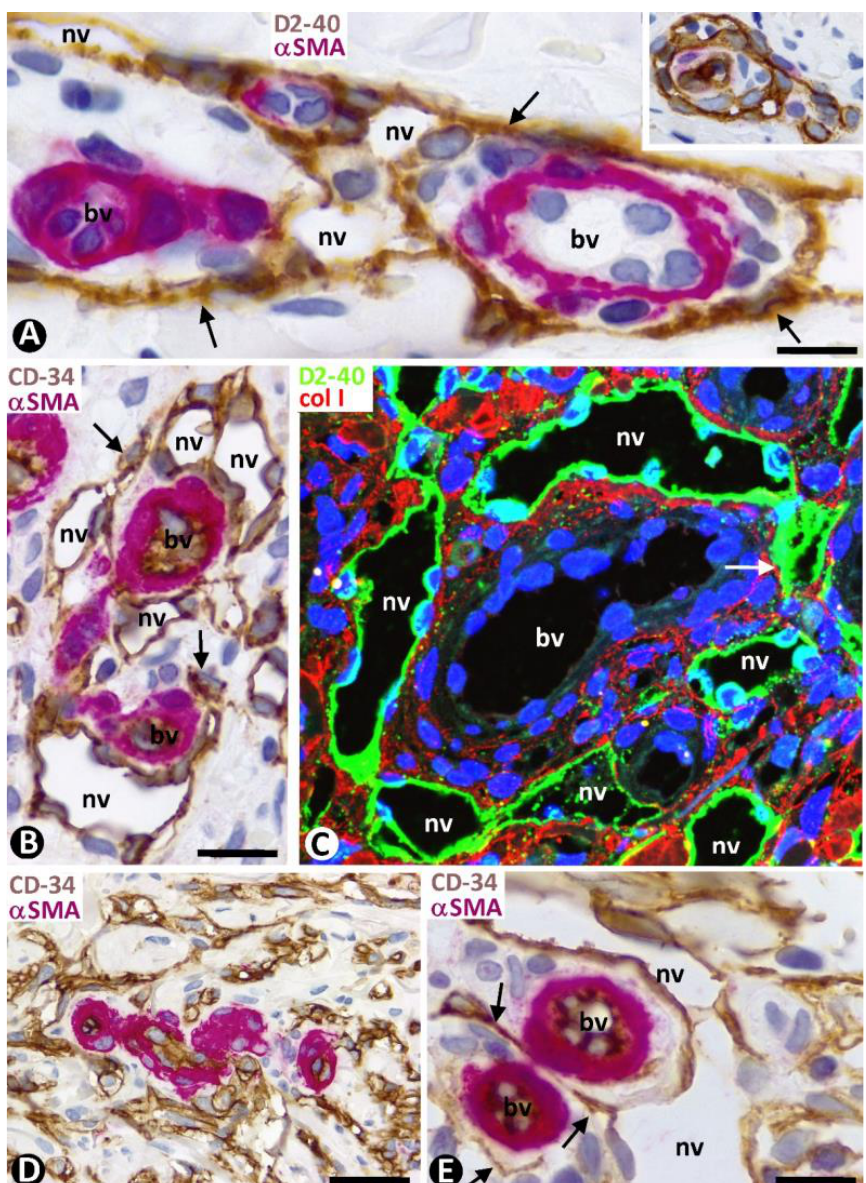
Figure 11. ( A ): All delimiting cells (brown, arrows) around blood vessels (bv), forming occasional and small neovessels lumen (nv), or not, are positive for D2-40. Insert of ( A ): ECs of neovessels with small lumens and interposed delimiting cells expressing CD34 (brown). ( B , C ): Delimiting cells (arrows) and ECs of dilated neovessel lumens (nv) expressing CD34: (( B ), brown) and D2-40 (( C ), green). ( D ): ECs of neovessels forming narrow cords (type 2 neovessels) (brown) around pre-existing blood vessels with pericytes (red) tangentially sectioned. ( E ): ECs of a dilated neovessel (nv, brown) continuous with a delimiting cell (brown, arrows) arranged between two pre-existing blood vessels (bv). Note that ECs of pre-existing blood vessels (bv) express CD34 (( B , D , E ) and insert of ( A )) but do not express D2-40 ( A , C ), while neovessel ECs express both markers of blood and lymphatic ECs (CD34 and D2-40). ( A ): Double immunochemistry for D2-40 and α SMA. ( B , D , E ) and insert in ( A ): Double immunochemistry for CD34 and α SMA. ( A , B , D , E ) and insert of ( A ): Hematoxylin counterstain. ( C ): Double immunofluorescence for D2-40 and collagen I. DAPI counterstain. Bar: ( A , C ): 15 µ m; ( B , E ): 20 µ m; ( D ): 35 µ